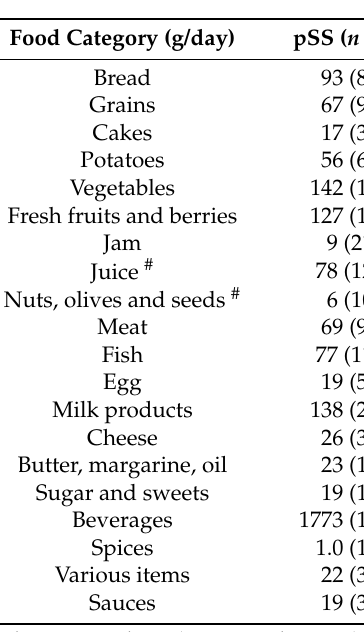
Table 2. Intake of food categories among the pSS-patients and the N3 reference group.